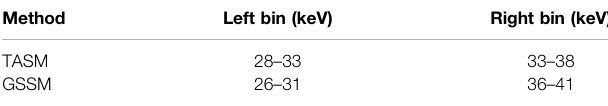
TABLE 4 | The energy bins used in comparison